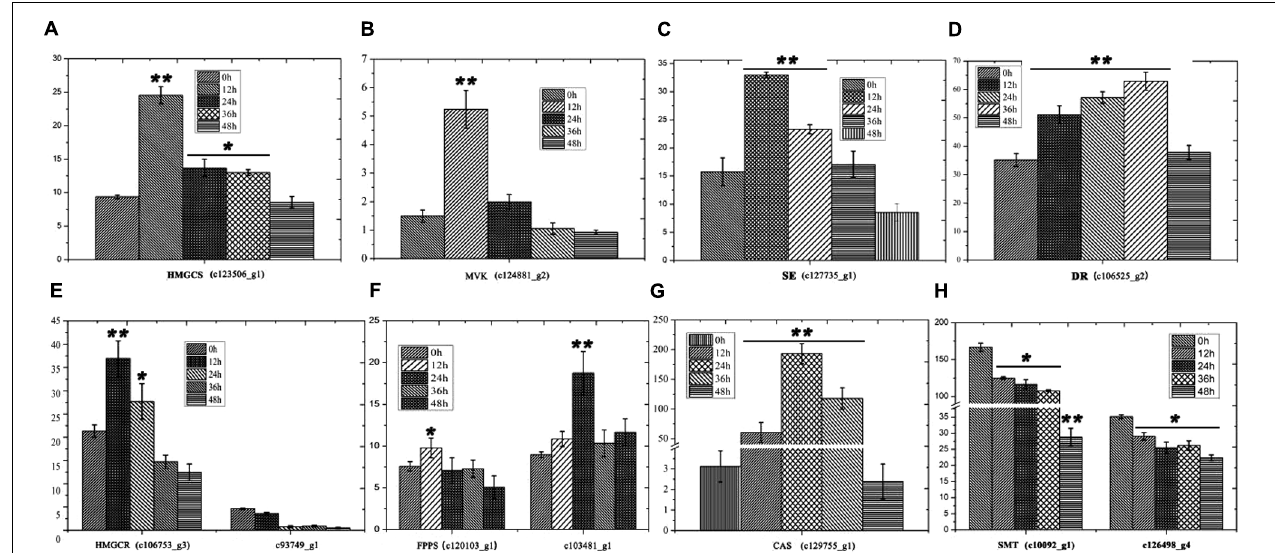
FIGURE 5 | Expression analysis of genes involved in the biosynthesis of cholesterol. (A) HMGS expression following treatment with MeJA. (B) MVK expression following treatment with MeJA. (C) SE expression following treatment with MeJA. (D) DR expression following treatment with MeJA. (E) HMGCR expression following treatment with MeJA. (F) FPPS expression following treatment with MeJA. (G) CAS expression following treatment with MeJA. Error bars are SD. Statistical significance was determined by Student’s t -test ( ∗ p ≤ 0.01; ∗∗ p ≤ 0.001).